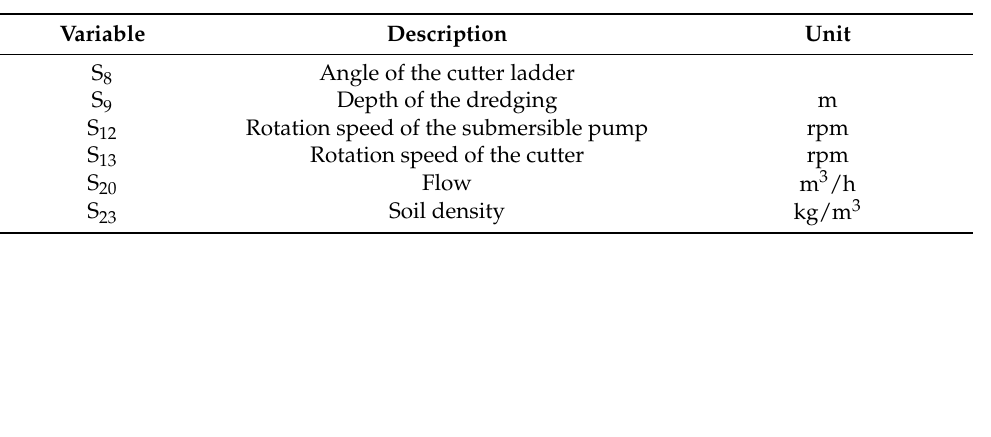
Table 1. Initial variables from the operational